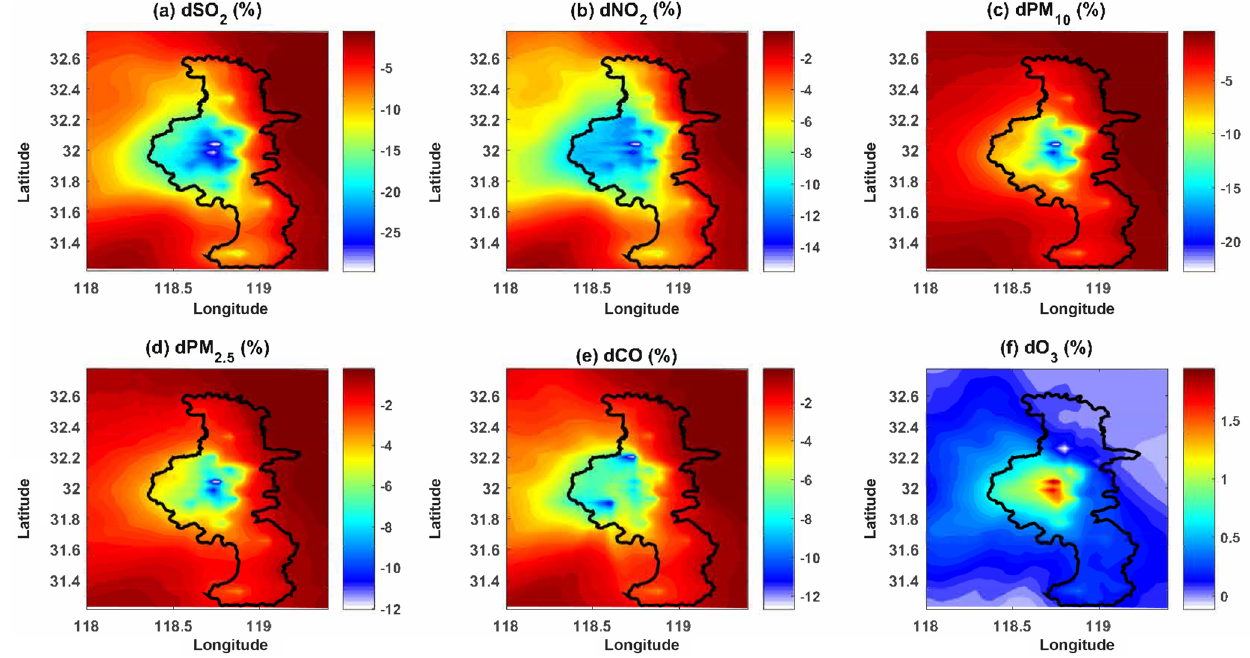
Figure 10. Influence of emission reduction on hourly mean concentrations of air pollutants in August 2014. Black thick lines draw the outline of Nanjing. Panels (a–f) are hourly average values of impact percentage (dspecies (%) = (Experiment 1 − Experiment 2) / Experiment 2 × 100%) of SO 2 , NO 2 , PM 10 , PM 2 . 5 , CO and O 3